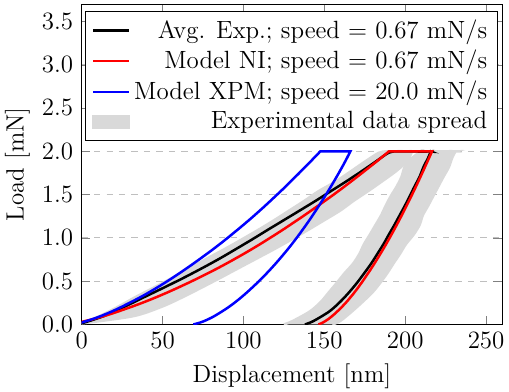
Figure 5. Calculated responses of NI and XPM loading with rate dependent viscoplastic